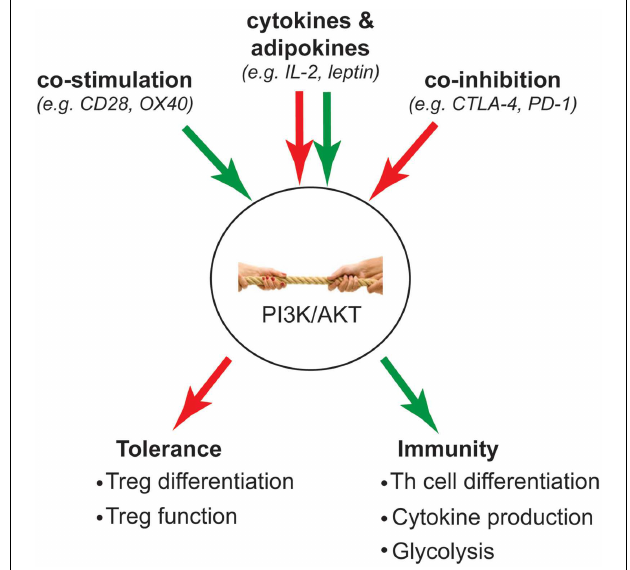
FIGURE 2 | Intracellular “tug-of-war” determinesT cell fate. Green arrow indicates activation of PI3K signaling; red arrow indicates inhibition of PI3K signaling.The strength of PI3K signaling is influenced by opposing activation and inhibitory signals that are integrated from extracellular stimuli such as co-stimulation, co-inhibition, and cytokines/adipokines. Ultimately, the outcome of this “tug-of-war” determines whether aT cell becomes a T reg to mediate tolerance, or inflammatoryTh subsets to mediate